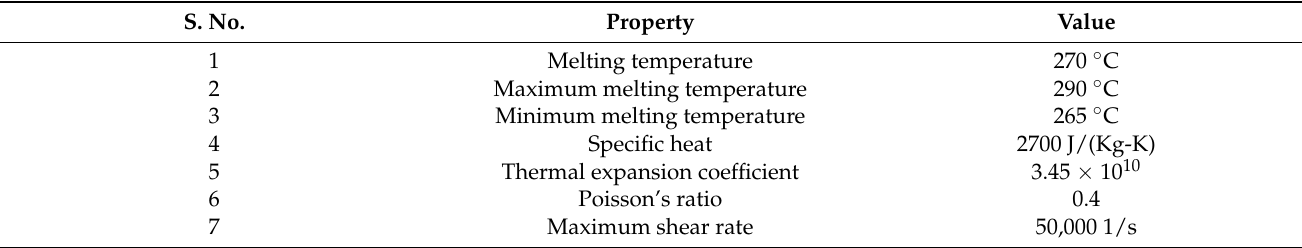
Table 1. Properties of the PET Generic Material used for 3D Model Simulation.